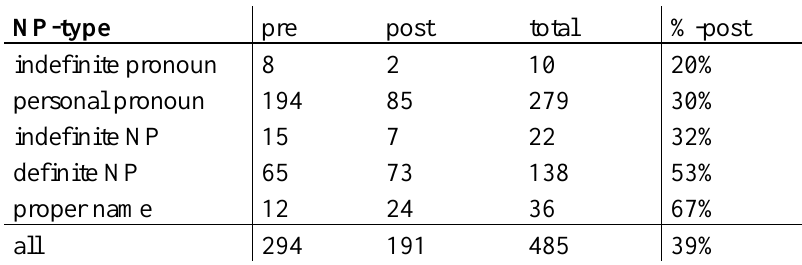
Table 8. Subject-verb inversion and the definiteness of